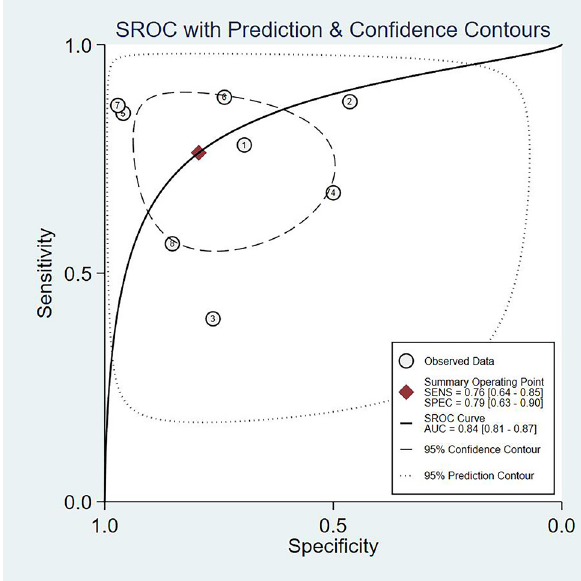
Figure 4: SROC curve plotted graph for the diagnostic value of miR - 92a in gastric